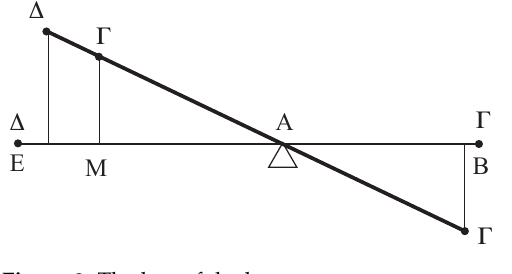
Figure 2. The law of the